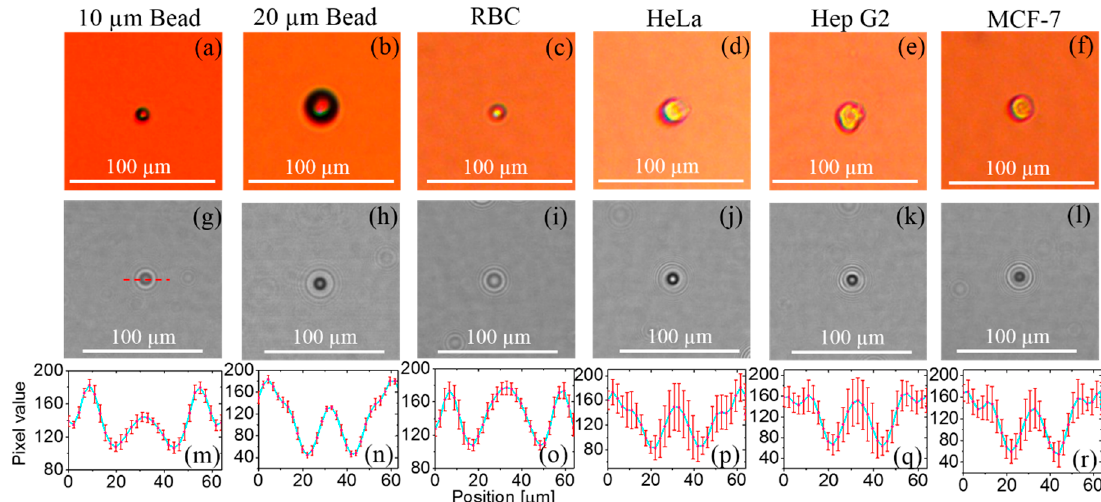
Figure 2. Diffraction pattern analysis. Optical micrographs of a single ( a ) 10 μ m bead; ( b ) 20 μ m bead; ( c ) RBC; ( d ) HeLa cell; ( e ) HepG2 cell; and ( f ) MCF7 cell; ( g )–( l ) diffraction images corresponding to ( a )–( f ), respectively, ( m )–( r ) intensity profiles corresponding to ( g )–( l ), with statistical differences of 10 samples from each of these cell lines.